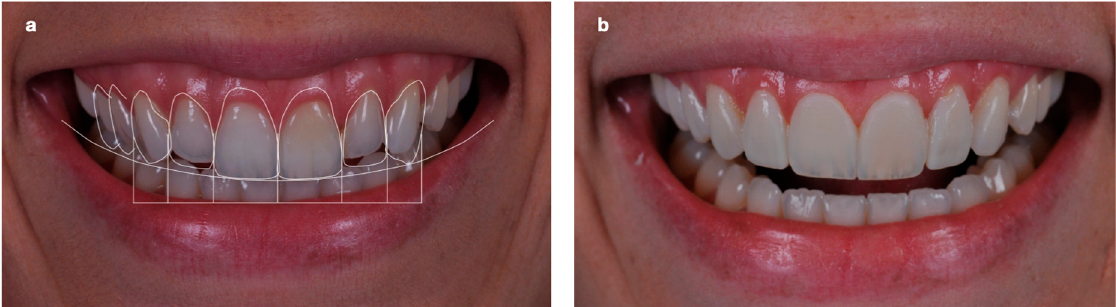
Figure 3. ( a ) Esthetic planning by a virtual analysis using DSD (Digital Smile Design). ( b ) Esthetic and functional evaluation by mock-up with bisacrylic resin.